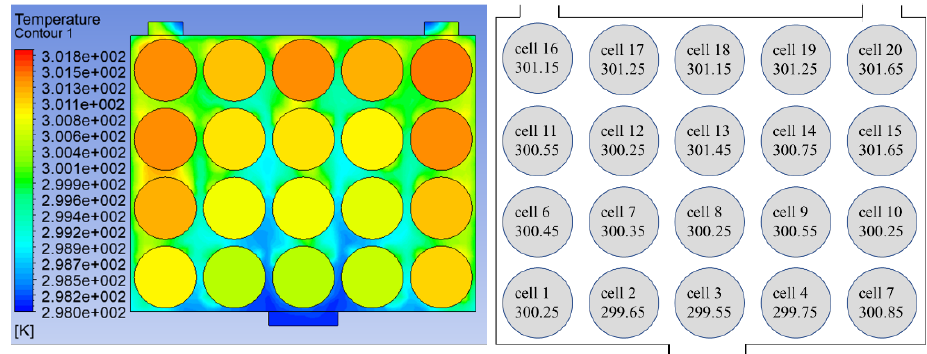
Figure 22. Comparison between the simulation and experimental results for scheme 13 (simulation on the left and experiment on the right).